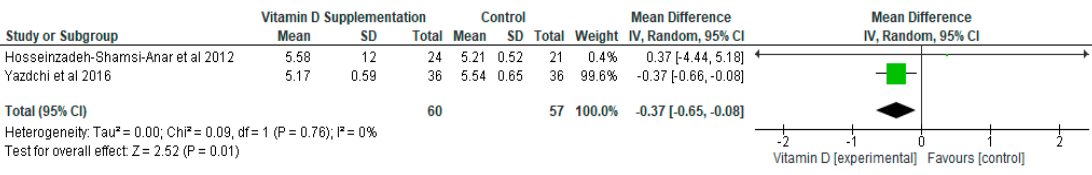
Figure 5. Forest plot of glycated haemoglobin (%).